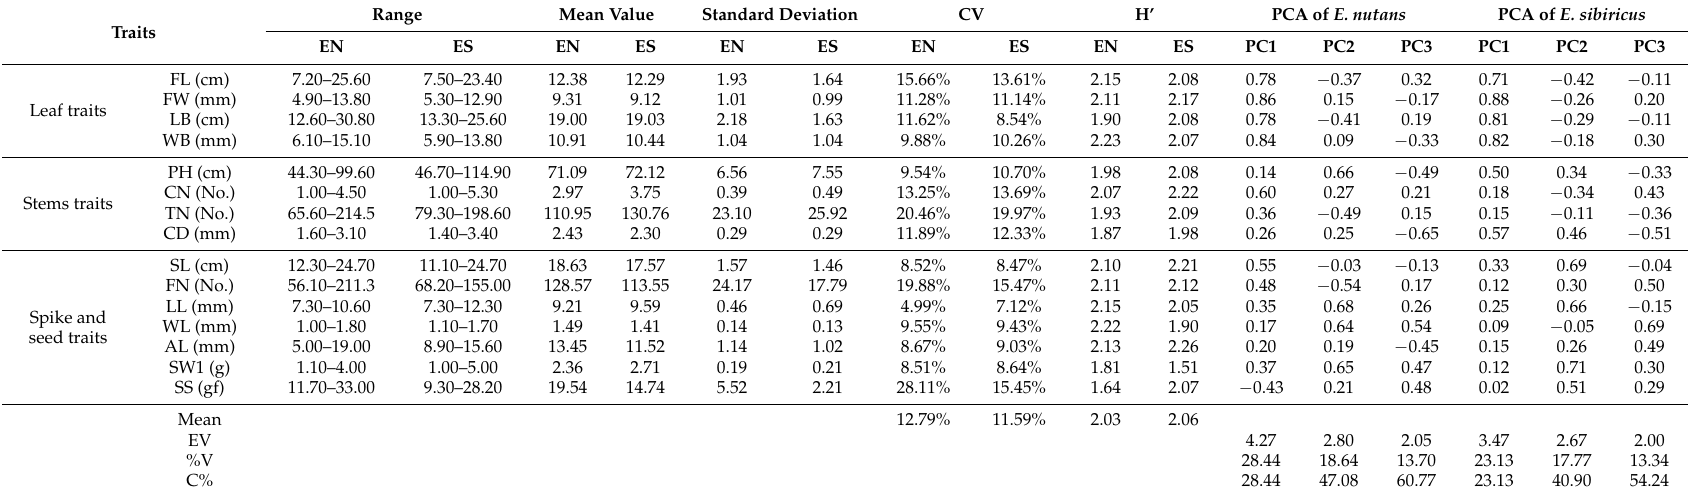
Table 2. The phenotypic diversity coefficient of 15 traits and the first three principal components of phenotypic variation for E. nutans (left) and E. sibiricus (right)